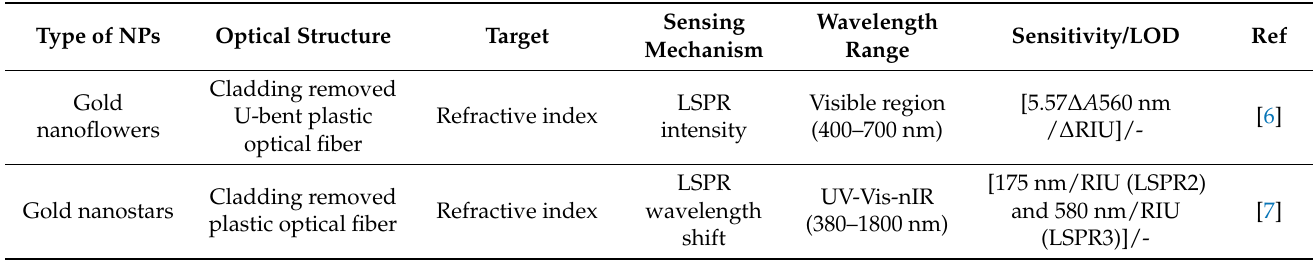
Table 1. Summary of the different optical fiber sensors composed of metallic nanoparticles with their corresponding optical structure, target of study, sensing mechanism, wavelength range and corresponding sensitivity. Type of